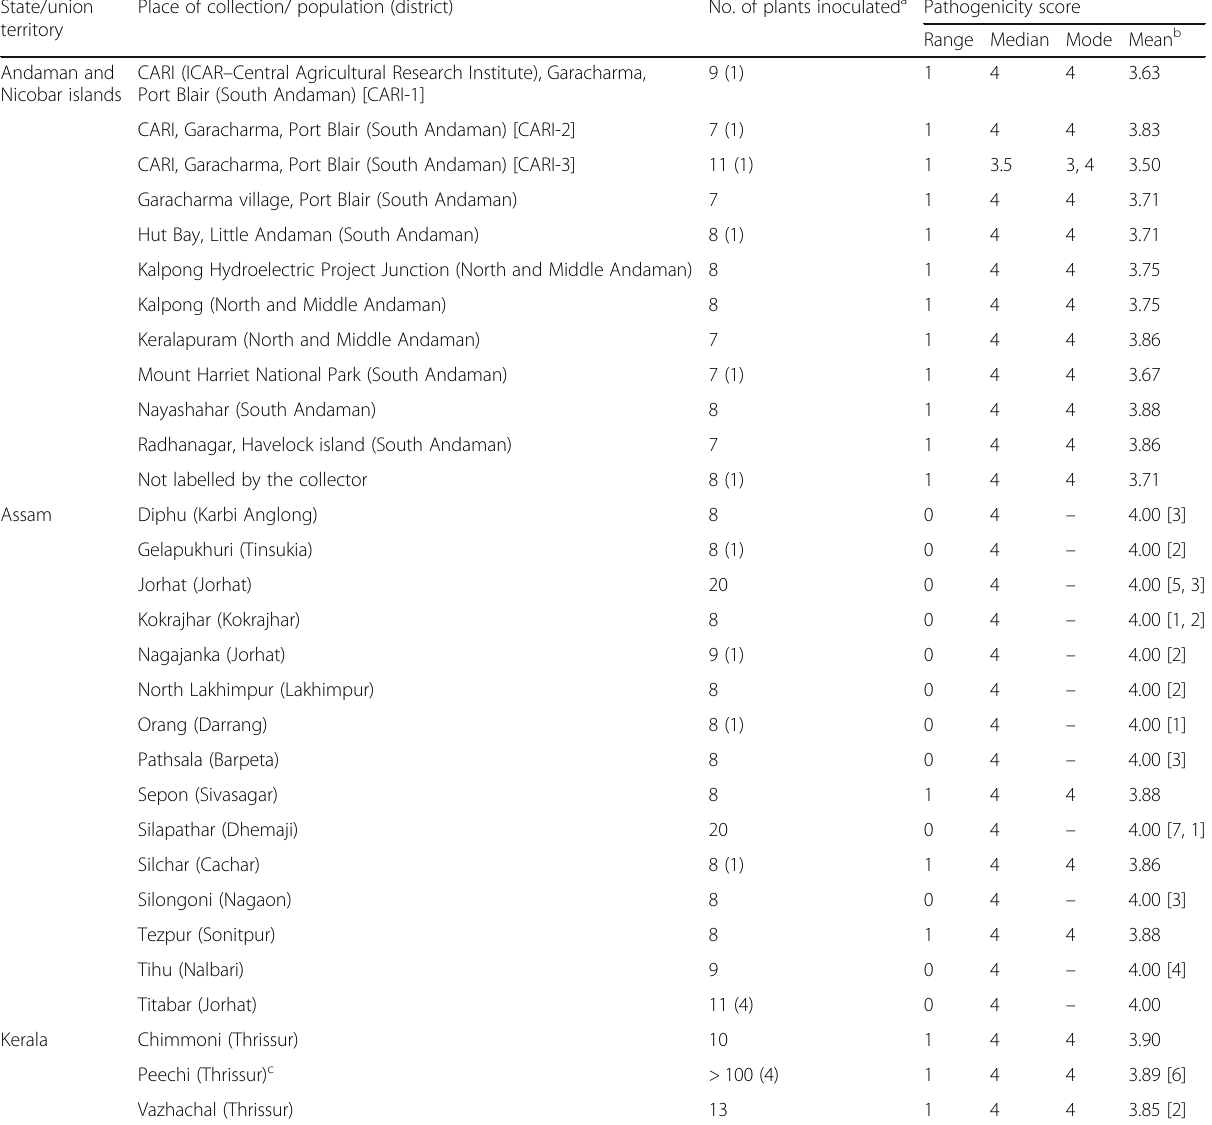
Table 1 Susceptibility of Mikania micrantha populations from different regions in India to Puccinia spegazzinii (Peruvian pathotype) State/union Place of collection/ population territory